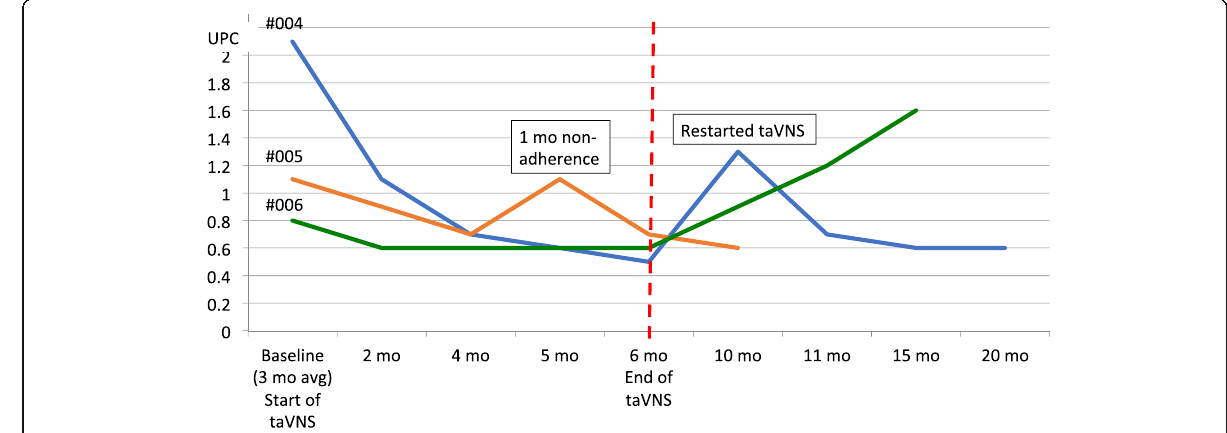
Fig. 2 Urine protein:creatinine change in steroid resistant nephrotic syndrome participants during the study and follow-up